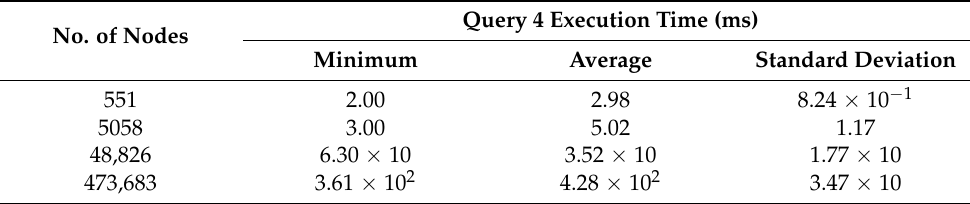
Table 6. Query 4 (contact tracing) execution time for different sizes of the graph